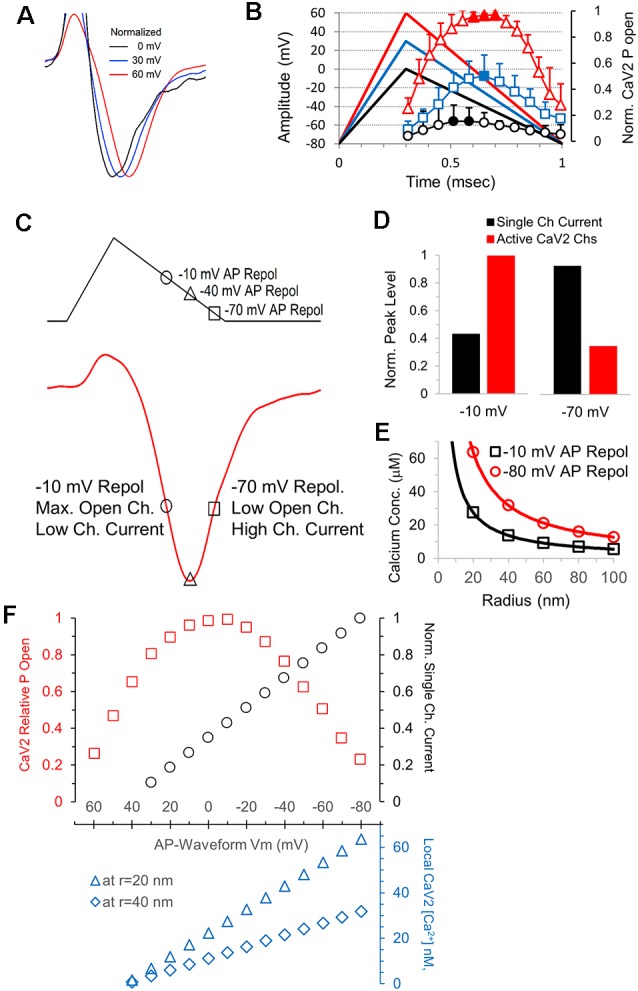
The electrical driving for calcium, not the number activated channels, determines the shape of the calcium channel response. (A) Responses shown in Figure 7 were normalized in amplitude to show how the time to reach peak amplitude increases as the amplitude of the stimulus voltage increases (60 mV, red; 30 mV, blue; and 0 mV, black. (B) Overlay of the AP-like stimuli and the CaV2 open probability data from Figure 7C shows the relationship between the stimulus time and the amount of CaV2 activation. (C) The AP-like stimulation and corresponding CaV2 current to show the relationship between the repolarization voltage at −10, −40 and −70 mV and the calcium current. The current at −10 and −70 mV are similar in this example, but the number of open calcium channels and the single-channel current differ greatly. (D) Graphs of the relative single-channel current (black) and CaV2 open probability (red) at repolarization values of −10 and −70 mV. The increased single-channel conductance at −70 mV offsets the reduction in the number of active calcium channels. (E) The single-channel current at when the AP repolarization is at −10 mV (black) and −80 mV (red) was used to calculate the local calcium concentration at individual CaV2 channels, at distances of 20–100 nm (radius). Channels that are still active at −80 mV have >2-fold higher local calcium concentrations than the channels that are active at −10 mV. (F) Graph of the relative CaV2 open probability, single-channel current, and local calcium concentrations during the AP-like repolarization from 60 to −80 mV. Local CaV2 calcium concentrations at the different membrane potentials are shown for a distance of 20 nm (blue triangles) and 40 nm (blue diamonds).